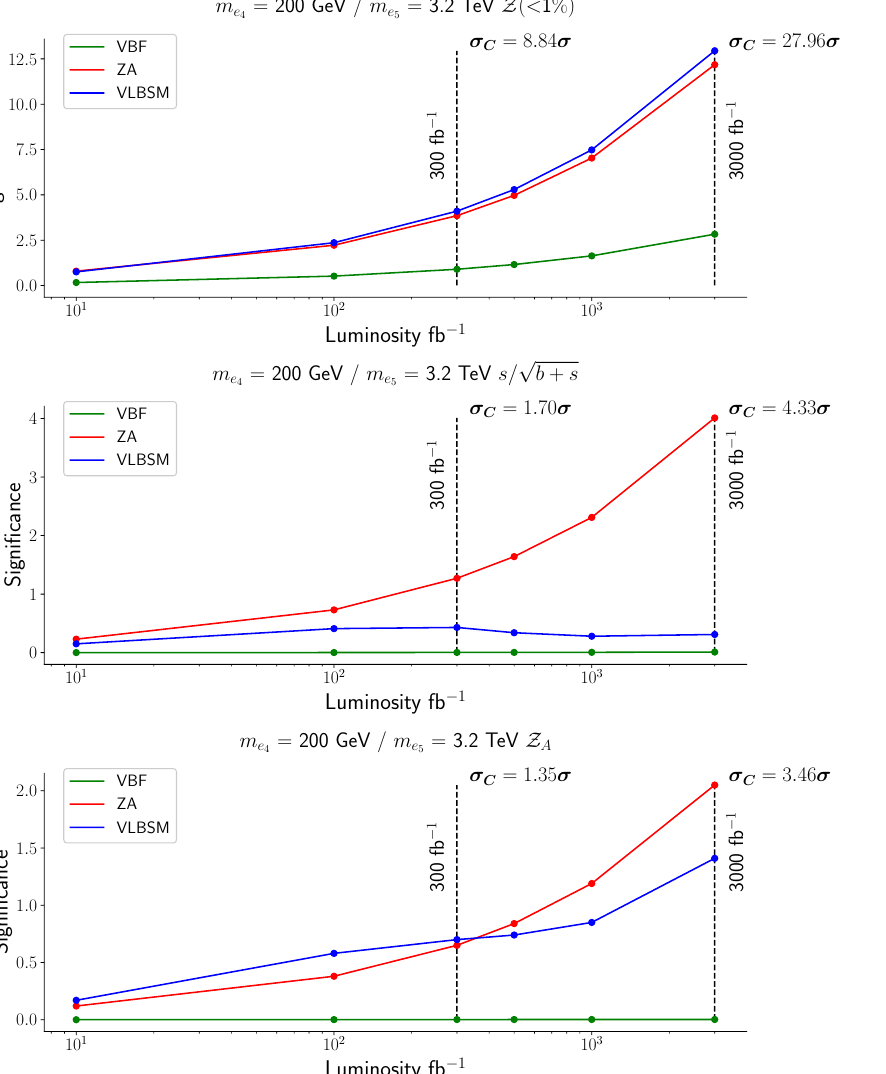
Figure 15. Significance as a function of the luminosity for different statistics and topologies that results from an evolutive algorithm that maximises accuracy. Here, x axis is in logarithmic scale for all plots and in the bottom plot the y axis is also in logarithmic scale. Green plots correspond to VBF signal events, red plots correspond to ZA signals and blue plots are representative of VLBSM topolo- gies. The top plot corresponds to the Asimov significance where backgrounds are exactly known with a systematics of 1%, the middle plot is representative of the naive significance ( σ = s/ the bottom plot corresponds to the Asimov significance where backgrounds are not exactly